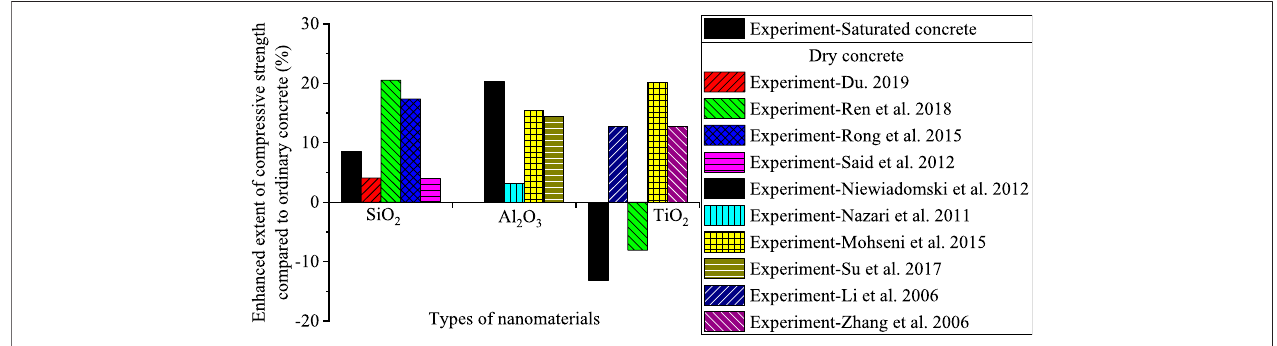
FIGURE 11 | The change in compressive strength of nano-concrete (at a nanomaterial content of 3 wt%) compared to ordinary concrete.